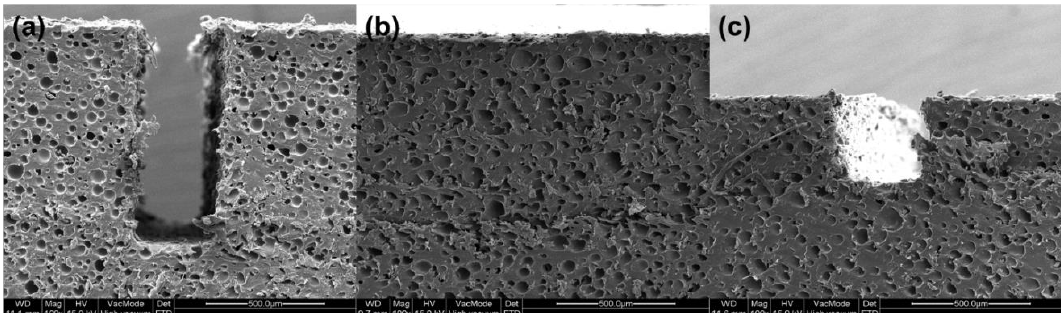
Figure 16. Within-wafer non-uniformities of Case I and II as a function of conditioning time.